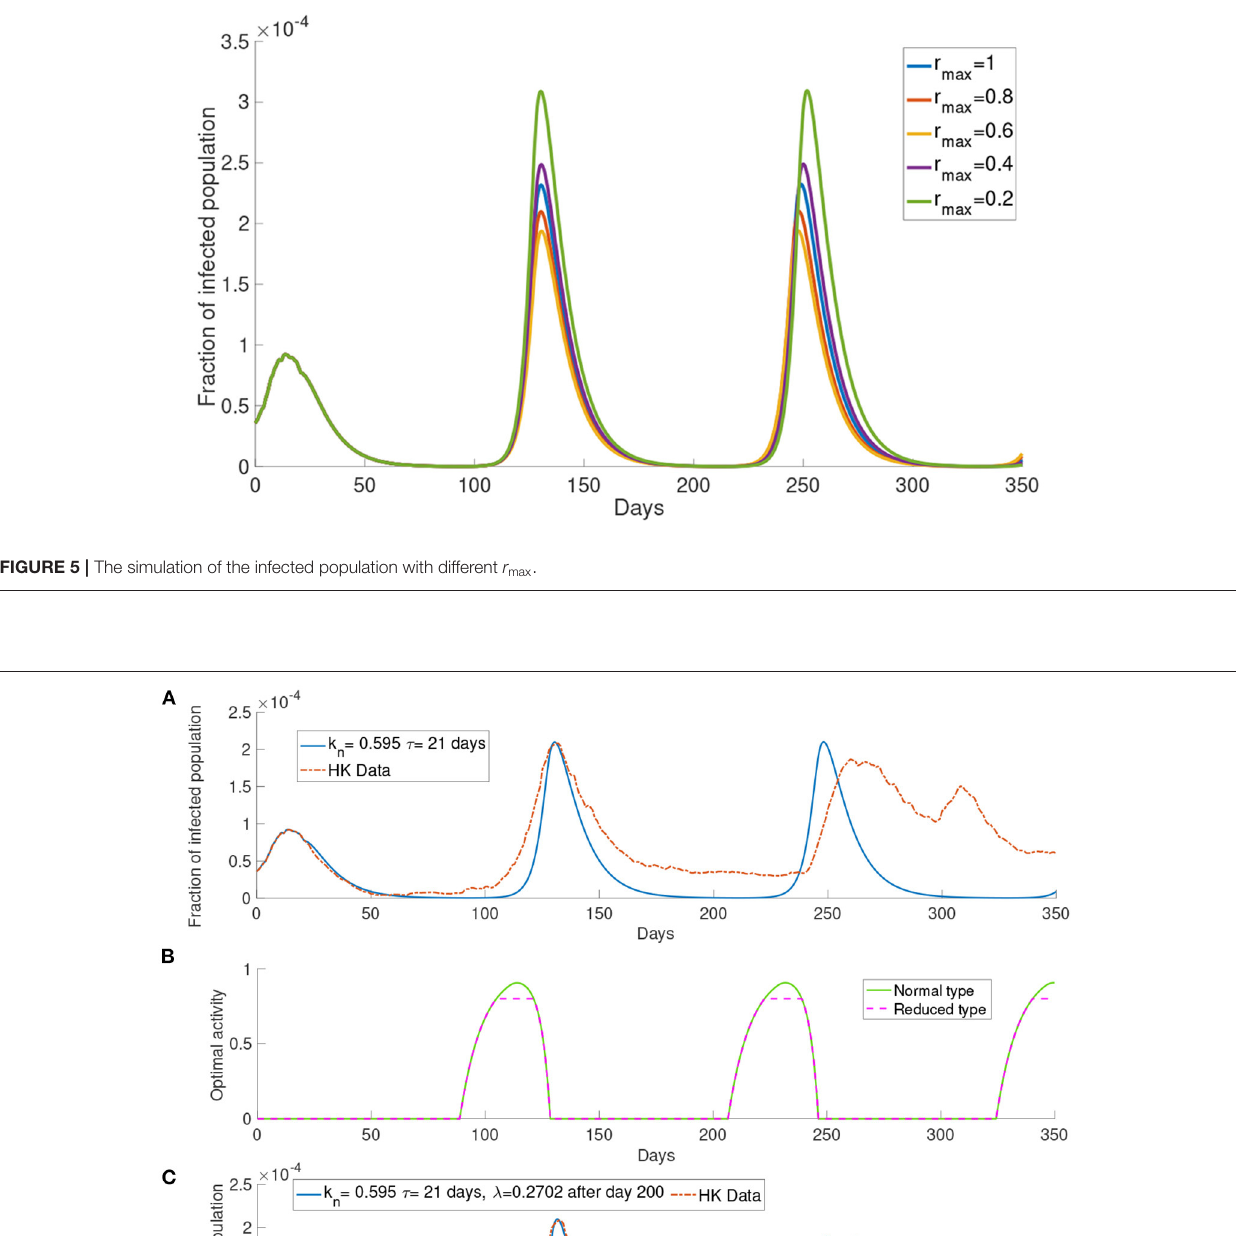
Frontiers in Public Health |